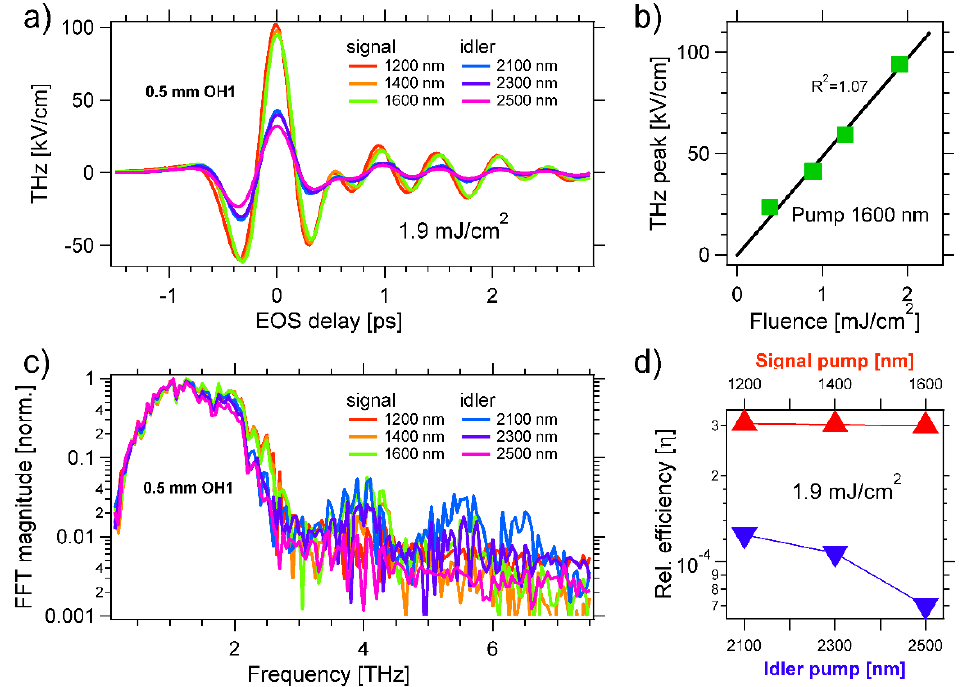
Figure 3. ( a ) Almost single-cycle THz fields emitted by optical rectification (OR) of optical parametric amplifier (OPA) pulses in a ~0.5 mm thick OH1 crystal. The pump fluence is set to 1.9 mJ/cm 2 . The THz is detected by EOS in a 0.5 mm thick GaP crystal. For EOS, we use an additional 90 fs sampling beam at 790 nm and chop the pump at 500 Hz. ( b ) We set the pump to λ P = 1600 nm and detect the peak THz field at t EOS = 0 ps versus pump fluence. A linear fit with an R 2 value of 1.07 is obtained, confirming that THz is emitted by an OR process. ( c ) Normalized spectrum of the THz field emitted as a function of λ P . The spectrum has high-frequency components around ca. 4 THz and between 5 and 7 THz, that are enhanced at λ P = 2100 nm. ( d ) Estimated conversion efficiency of infrared into THz radiation by OH1 as a function of λ P . The efficiency is η ~3 × 10 − 4 between 1200 and 1600 nm, and is smaller when pumped by the idler.